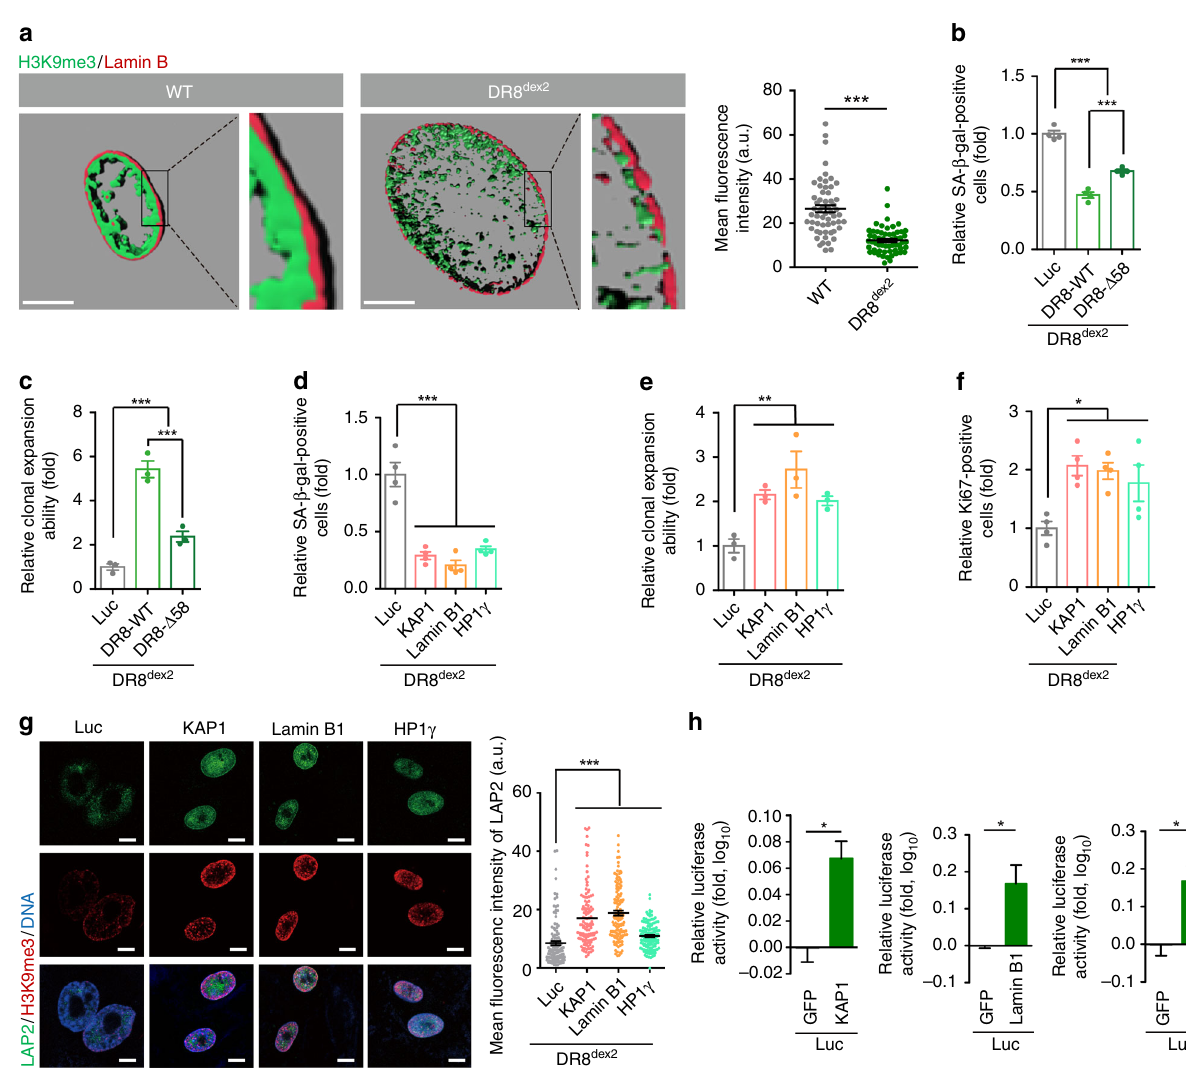
Fig. 5 DGCR8 and its interacting proteins are required for the homeostatic maintenance of hMSCs. a Left, 3D construction of a z stack of H3K9me3 and Lamin B immuno fl uorescence images shown in supplementary Fig. 7i of WT and DR8 dex2 hMSCs. Scale bar, 10 μ m. Right, mean fl uorescence intensity of H3K9me3 in supplementary Fig. 7i was measured by ImageJ. Data were presented as mean ± SEM. n = 60 cells per cell type, *** p < 0. 001. b SA- β -gal staining of DR8 dex2 hMSCs transduced with lentiviruses expressing Luc, DR8-WT (1-773), or DR8- Δ 58. Data were presented as mean ± SEM. n = 4 images per condition, *** p < 0.001. c Clonal expansion analysis of DR8 dex2 hMSCs transduced with lentiviruses expressing Luc, DR8-WT (1-773), or DR8- Δ 58. Data were presented as mean ± SEM. n = 3 wells per condition, *** p < 0.001. d SA- β -gal staining of DR8 dex2 hMSCs transduced with lentiviruses expressing Luc, KAP1, Lamin B1, or HP1 γ . Data were presented as mean ± SEM. n = 4 images per condition, *** p < 0.001. e Clonal expansion analysis of DR8 dex2 hMSCs transduced with lentiviruses expressing Luc, KAP1, Lamin B1, or HP1 γ . Data were presented as mean ± SEM. n = 3 wells per condition, ** p < 0.01. f Ki67 staining of DR8 dex2 hMSCs transduced with lentiviruses expressing Luc, KAP1, Lamin B1, or HP1 γ . Data were presented as mean ± SEM. n = 4 images per condition, * p < 0.05. g Immunostaining of LAP2 and H3K9me3 in DR8 dex2 hMSCs transduced with lentiviruses expressing Luc, KAP1, Lamin B1, or HP1 γ . Scale bar, 10 μ m. Mean fl uorescence intensity of LAP2 was calculated. Data were presented as mean ± SEM. n = 120 cells per condition. *** p < 0.001. h Photon fl ux from tibialis anterior (TA) muscles of nude mice transplanted with DR8 dex2 hMSCs with co-infection of lentiviral vectors expressing GFP or KAP1 (left)/Lamin B1 (middle)/HP1 γ (right) and lentiviral vector expressing luciferase. Luciferase activity in the TA muscles was detected by an in vivo imaging system (IVIS) 4 days after implantation, demonstrating slower attrition of DR8 dex2 hMSCs transduced with KAP1, Lamin B1, or HP1 γ . Data were presented as mean ± SEM. n = 3 mice per group, * p < 0.05. Statistical signi fi cances were assessed by a two-tailed unpaired Student ’ s t